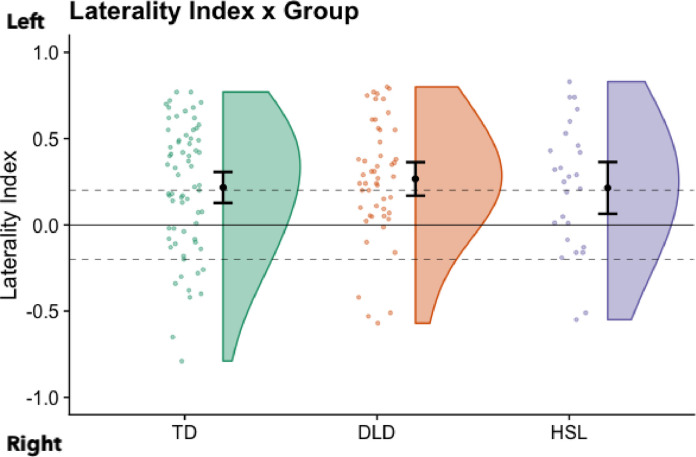
Laterality indices for verb generation evoked activity in the frontal lobes. Data for individual participants is shown (TD in green, DLD in orange, and HSL in purple). Black points show the mean for each group. Error bars represent +/- 95% confidence intervals. Laterality indices above the centre y = 0 line represent left lateralisation and values below this line represent right lateralisation. Additional lines have been placed at 0.2 and −0.2 as an indication of divisions for left, bilateral, and right lateralisation.